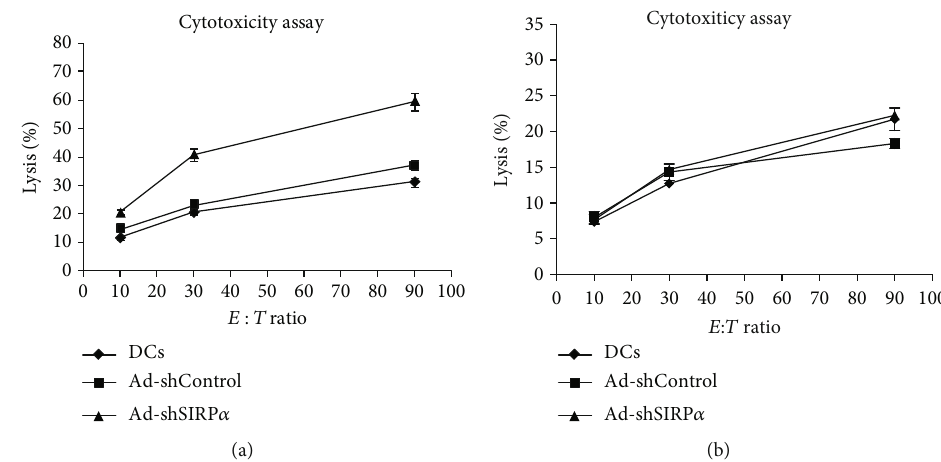
Figure 3: Cytotoxicity assay. The DC-induced CTL response against the HPV16E7-expressing tumor was determined using a CCK8 kit. After 2 weeks of immunization, the pooled splenocytes from each group were used as e ff ector cells. Their speci fi c lytic activities against TC-1 cells at 90: 1, 30:1, and 10 :1 E : T ratios were assayed. Ad-shSIRP α -transduced DCs induced the strongest speci fi c CTL responses against TC-1 cells compared with the Ad-shControl group. The lytic activities against TC-1 of Ad-shSIRP α -transduced DCs were similar to those of the Ad- shControl group after CD8 + T cell elimination with anti-CD8 monoclonal antibody.